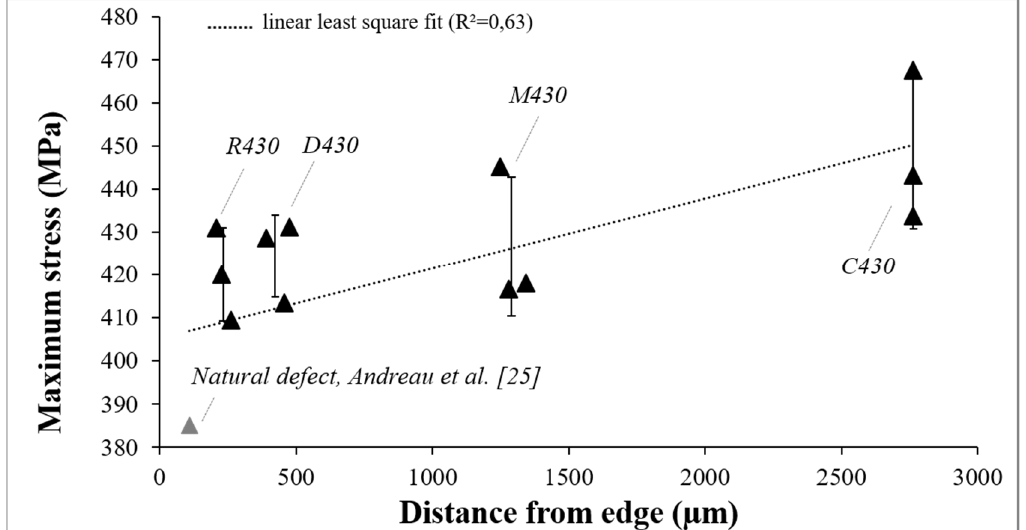
Figure 12. Influence of defect position on the fatigue limit of 316L LPBF (size of defect R = 214 µm) [13].